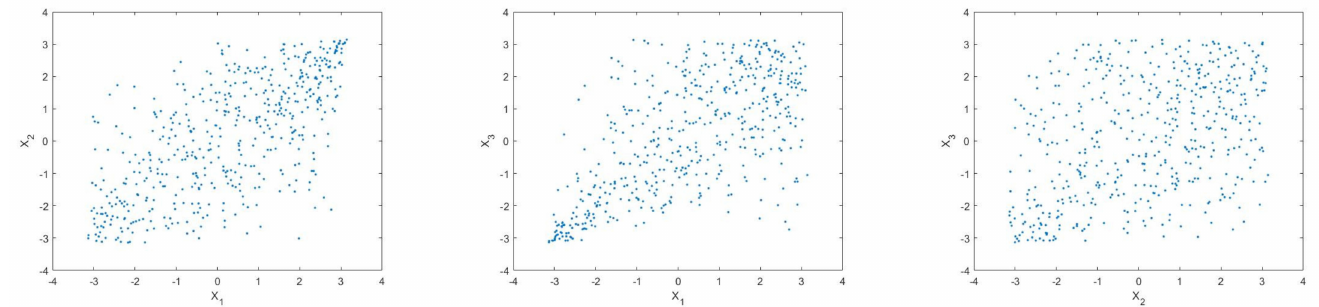
Figure 7. Sample distribution of input variables ( N = 500).